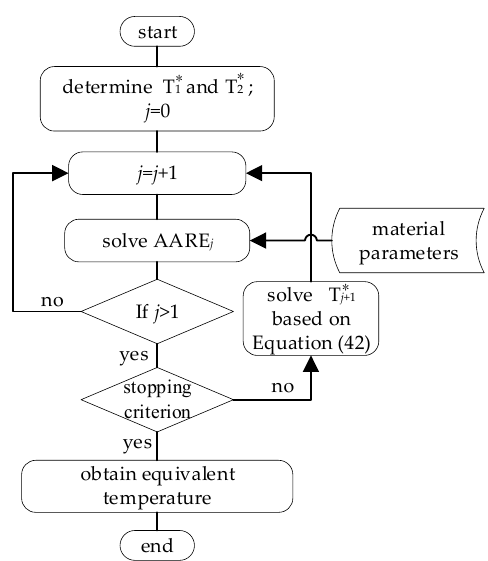
Figure 18. The process of solving a single equivalent temperature in the mHS equation by combining multiple regression analysis with a linear search.